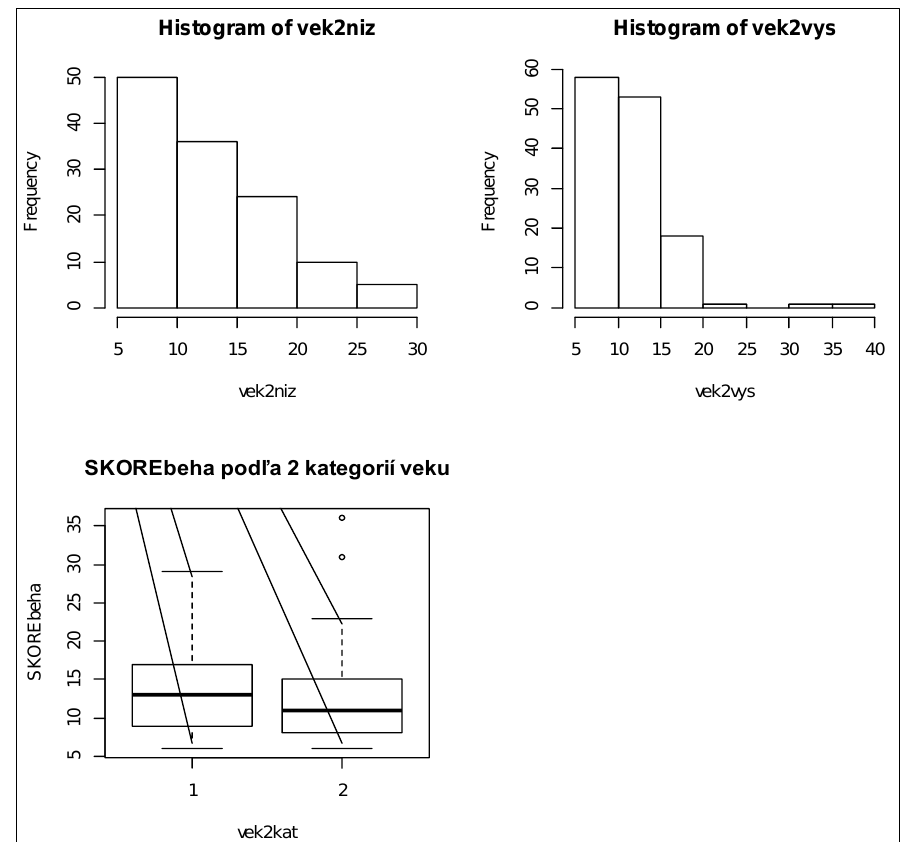
Figure 3. Frequency distribution of the scores for the behavioural component – age groups